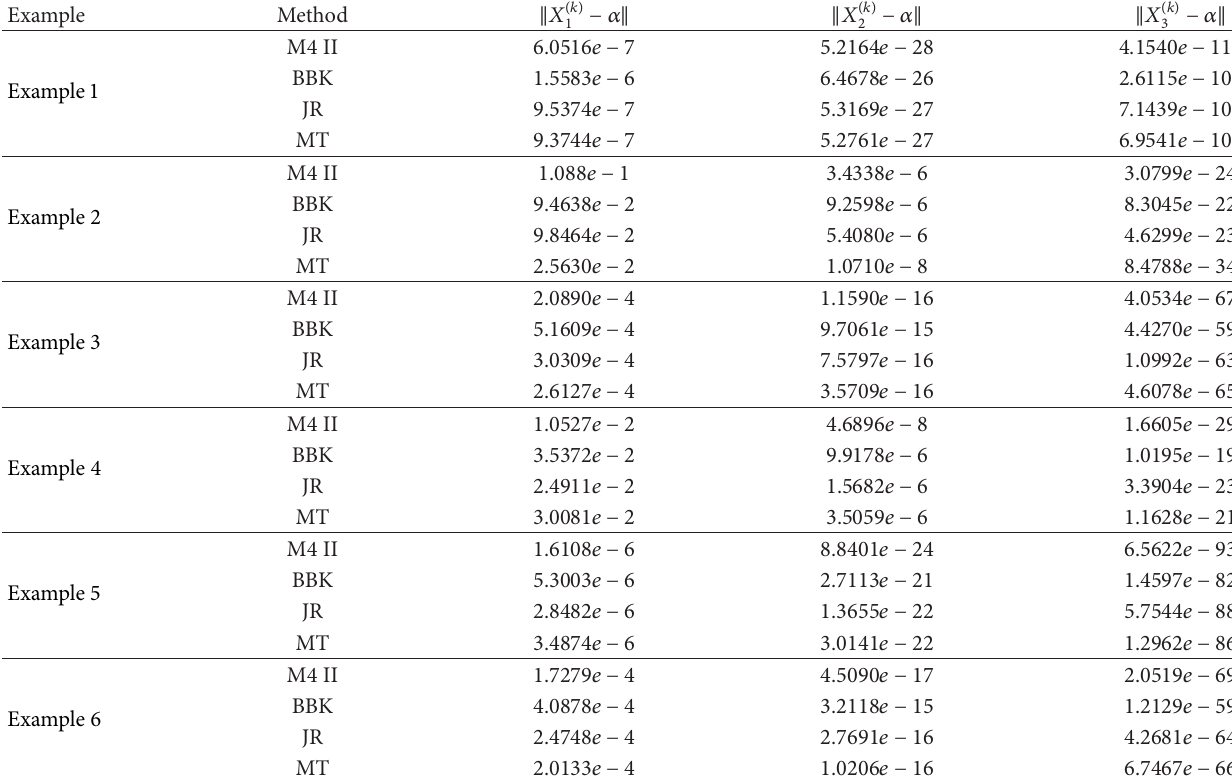
Table 6: Comparison of the norm of the error occurring in the estimates of the exact root with some existing fourth-order methods.